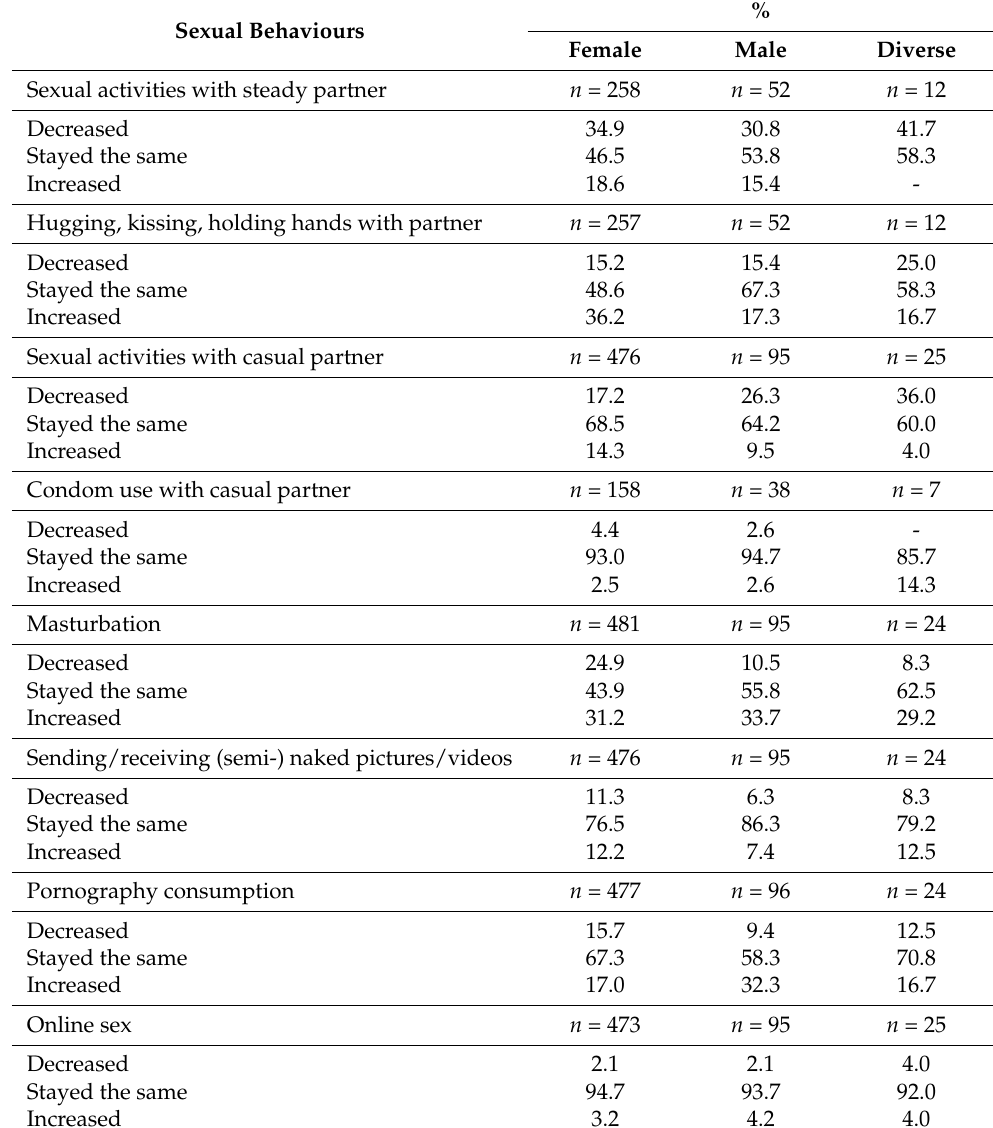
Table 5. Changes in sexual behaviours during COVID-19 social distancing measures. Sexual Behaviours